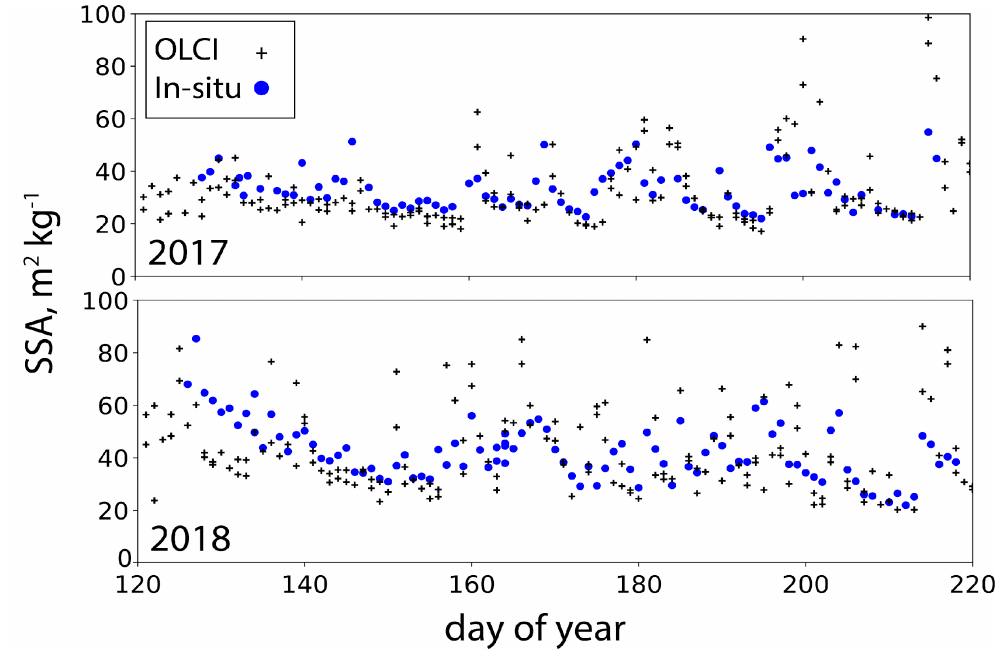
Figure 17. Comparison of OLCI retrievals of snow Specific Surface Area (SSA) from the average of 10 ground observations each day along a 90 m transect at the EGP location on Greenland. Table 5. Comparison of OLCI surface (0–1 cm depth) snow grain size retrieval in comparison with in-situ observations.